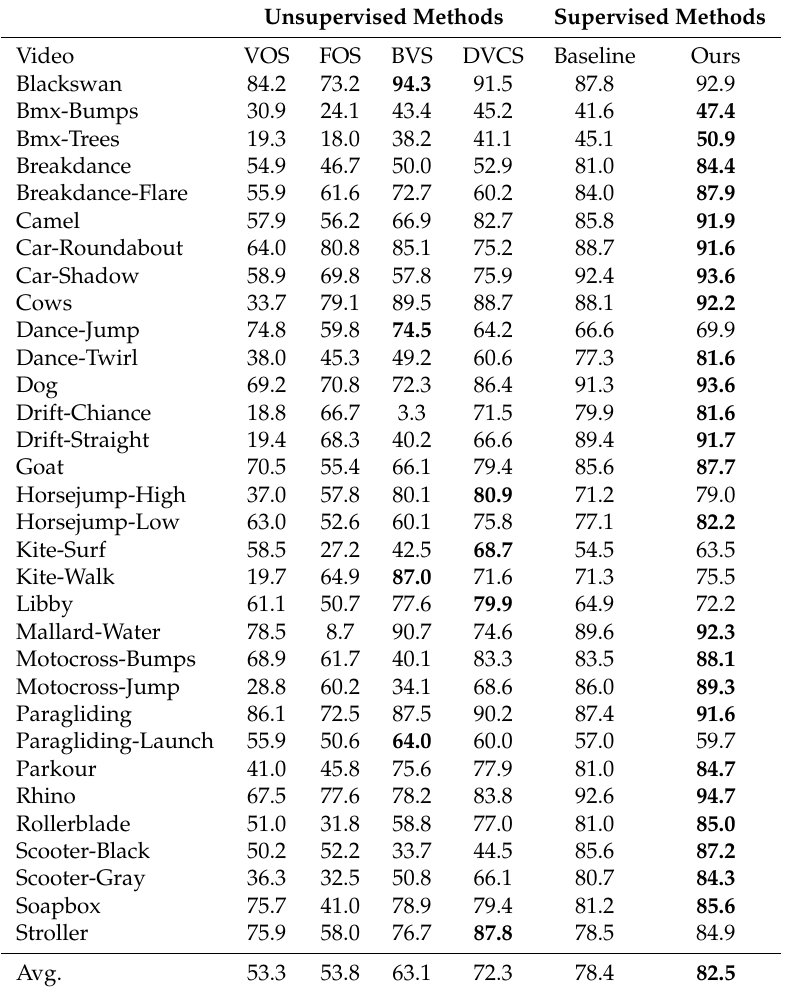
Table 2. The average intersection-over-union (IoU) scores of our framework, baseline (ResNet), and four video object segmentation methods on the DAVIS dataset. Four video object segmentation methods are unsupervised learning methods; the baseline and our framework are supervised learning methods. Numbers in bold are the best performance of each